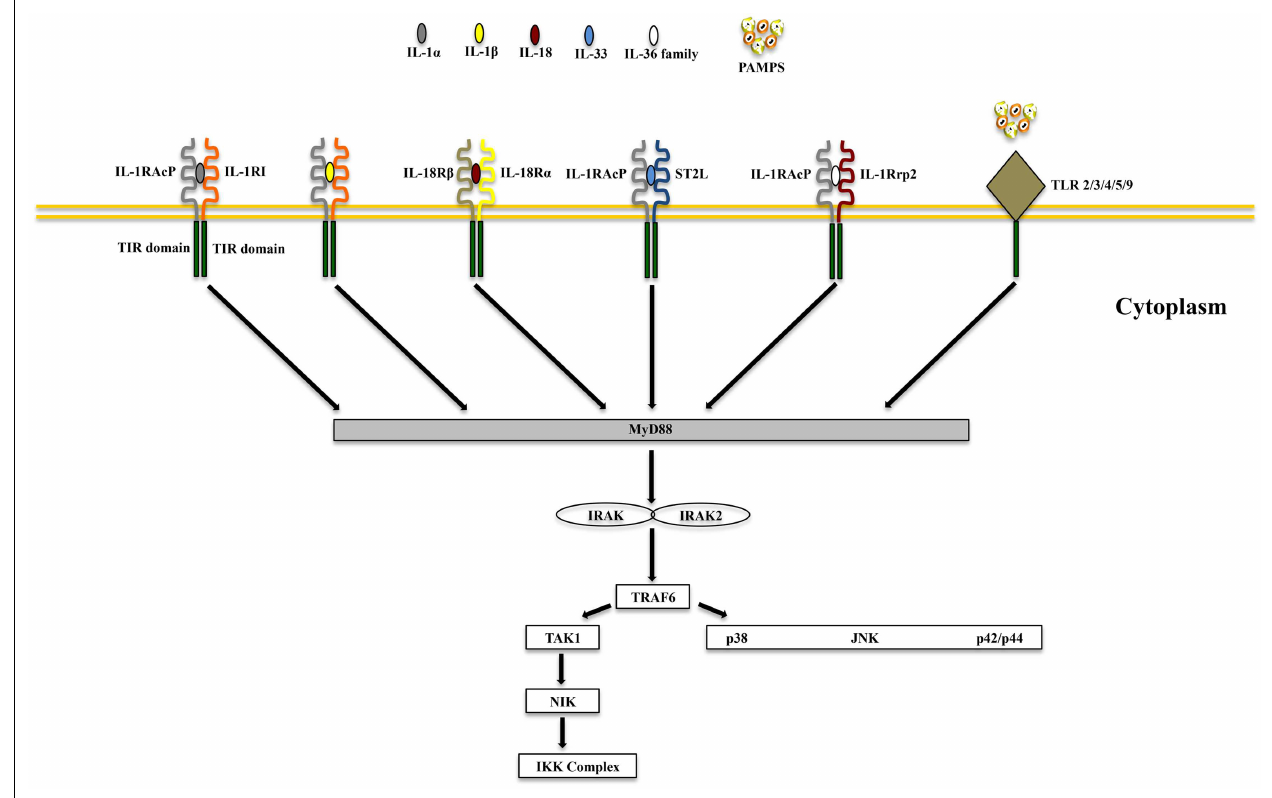
IL-36.TheTIR domain is essential for recruitment of cytoplasmic adapter proteins, which in turn initiates downstream signaling cascades. PAMPS, pathogen-associated molecular